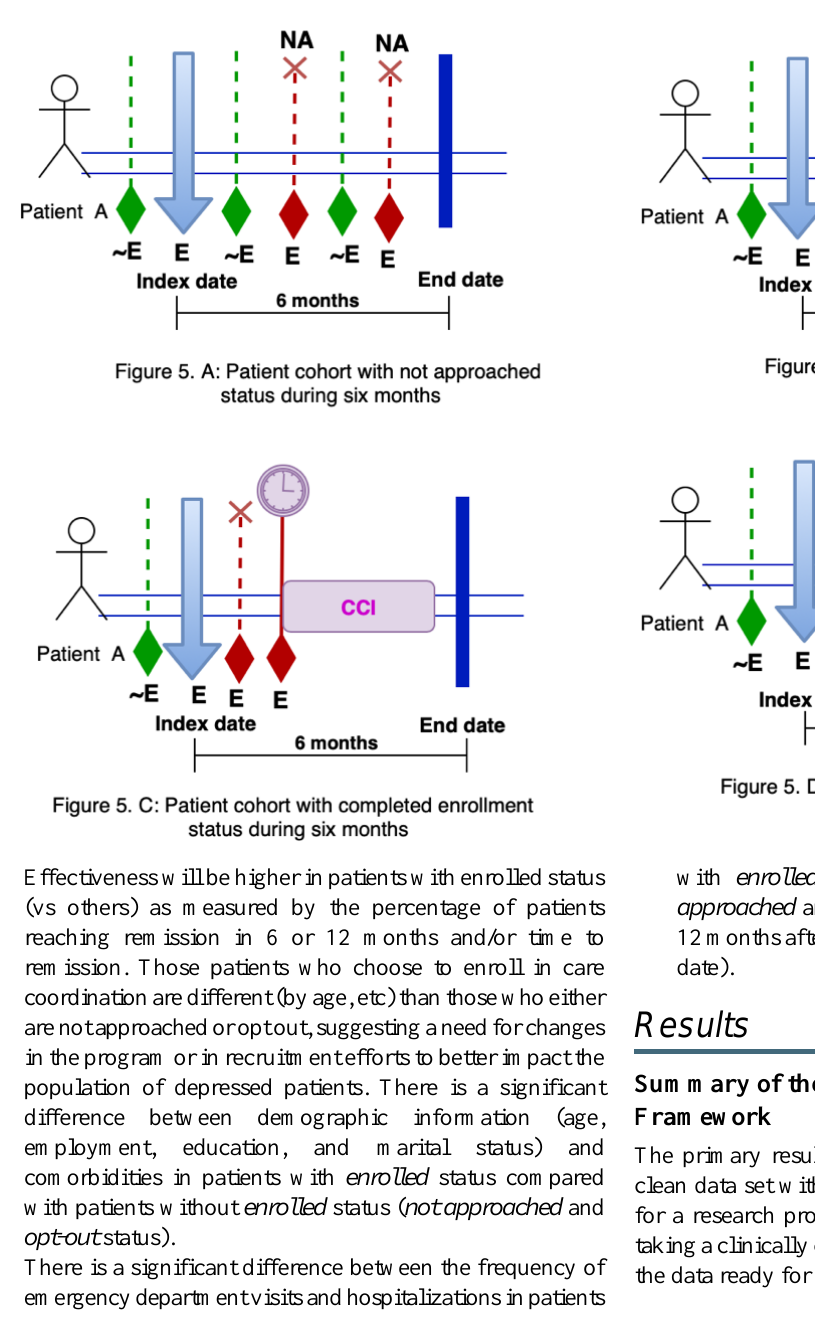
Figure 4. The identified patient cohorts for a cross-sectional study. CCI: care coordination intervention; E: eligible; ~E: not eligible; NA: not